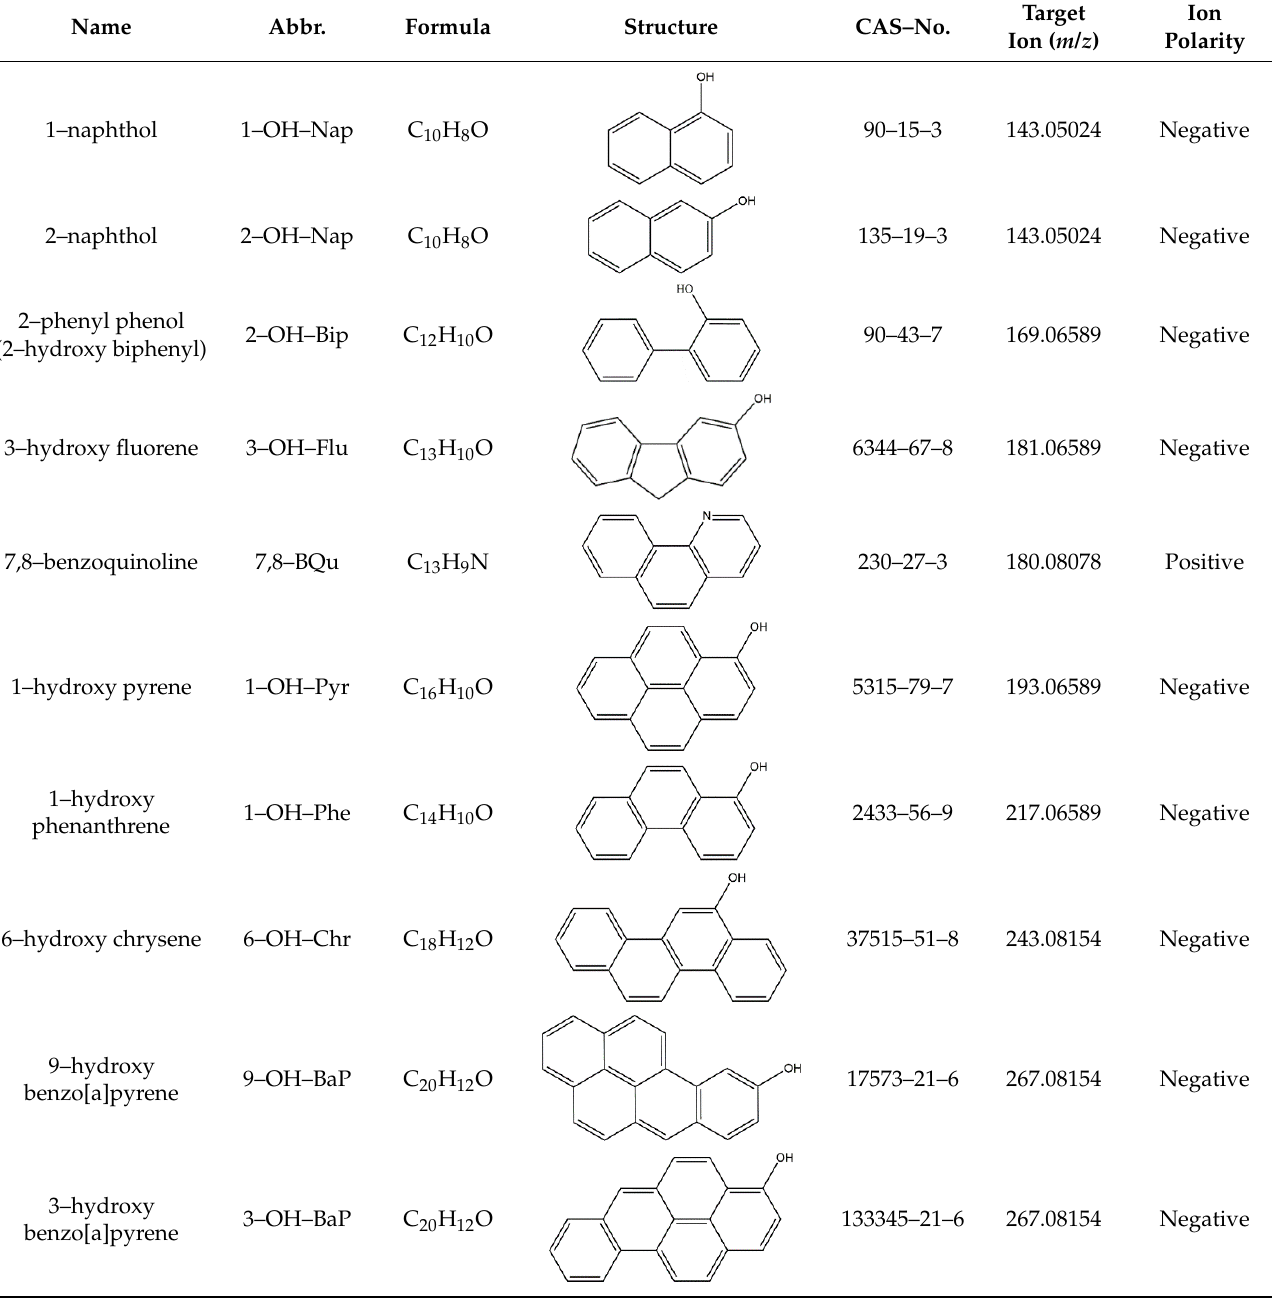
Table 1. Detailed information on target compounds .